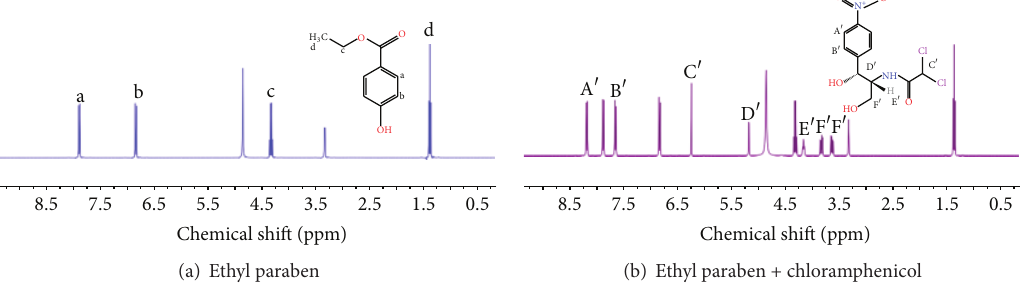
Figure 1: The H-NMR spectra of (a) internal standard (ethyl paraben and methanol-D 4 ) and (b) sample solution (chloramphenicol, ethyl paraben, and methanol-D 4